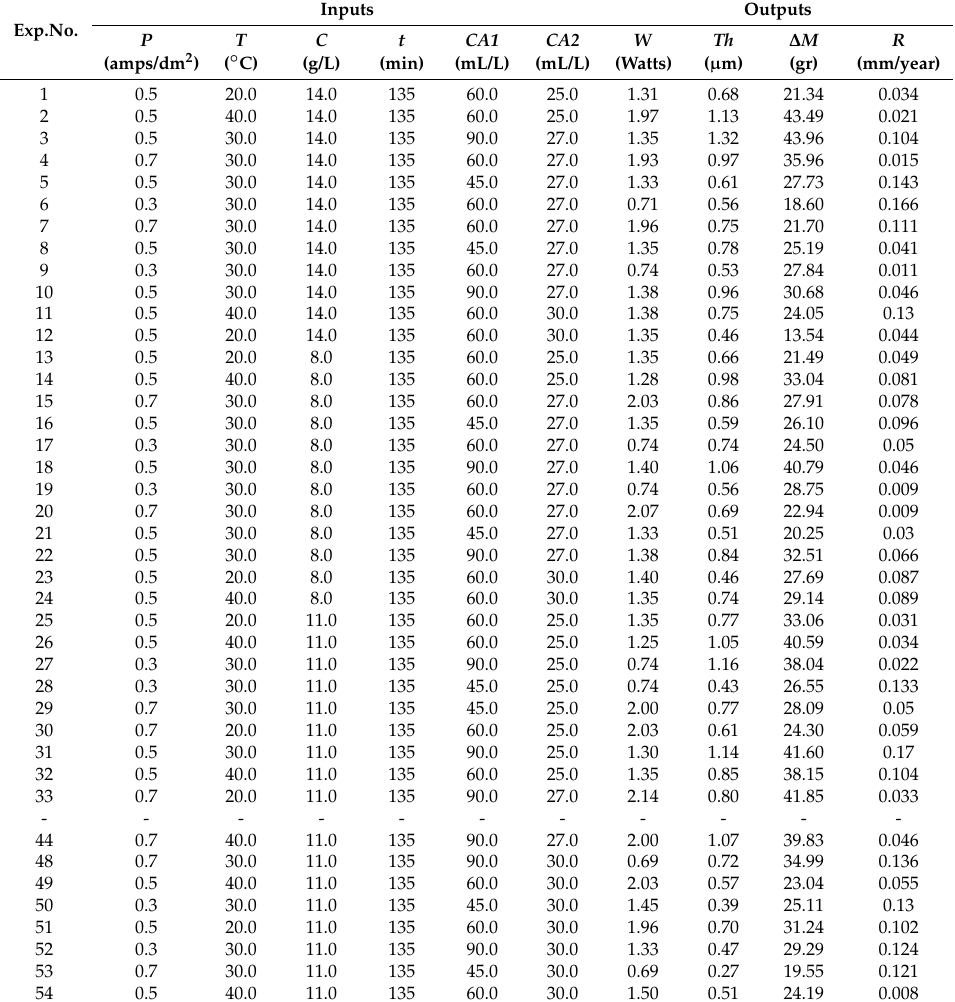
Table 2. Design matrix and experiments obtained by BBD. ρ , current density; T , temperature; C , concentration; t , time; CA1 , concentration Additive 1; and CA2 , concentration Additive 2.